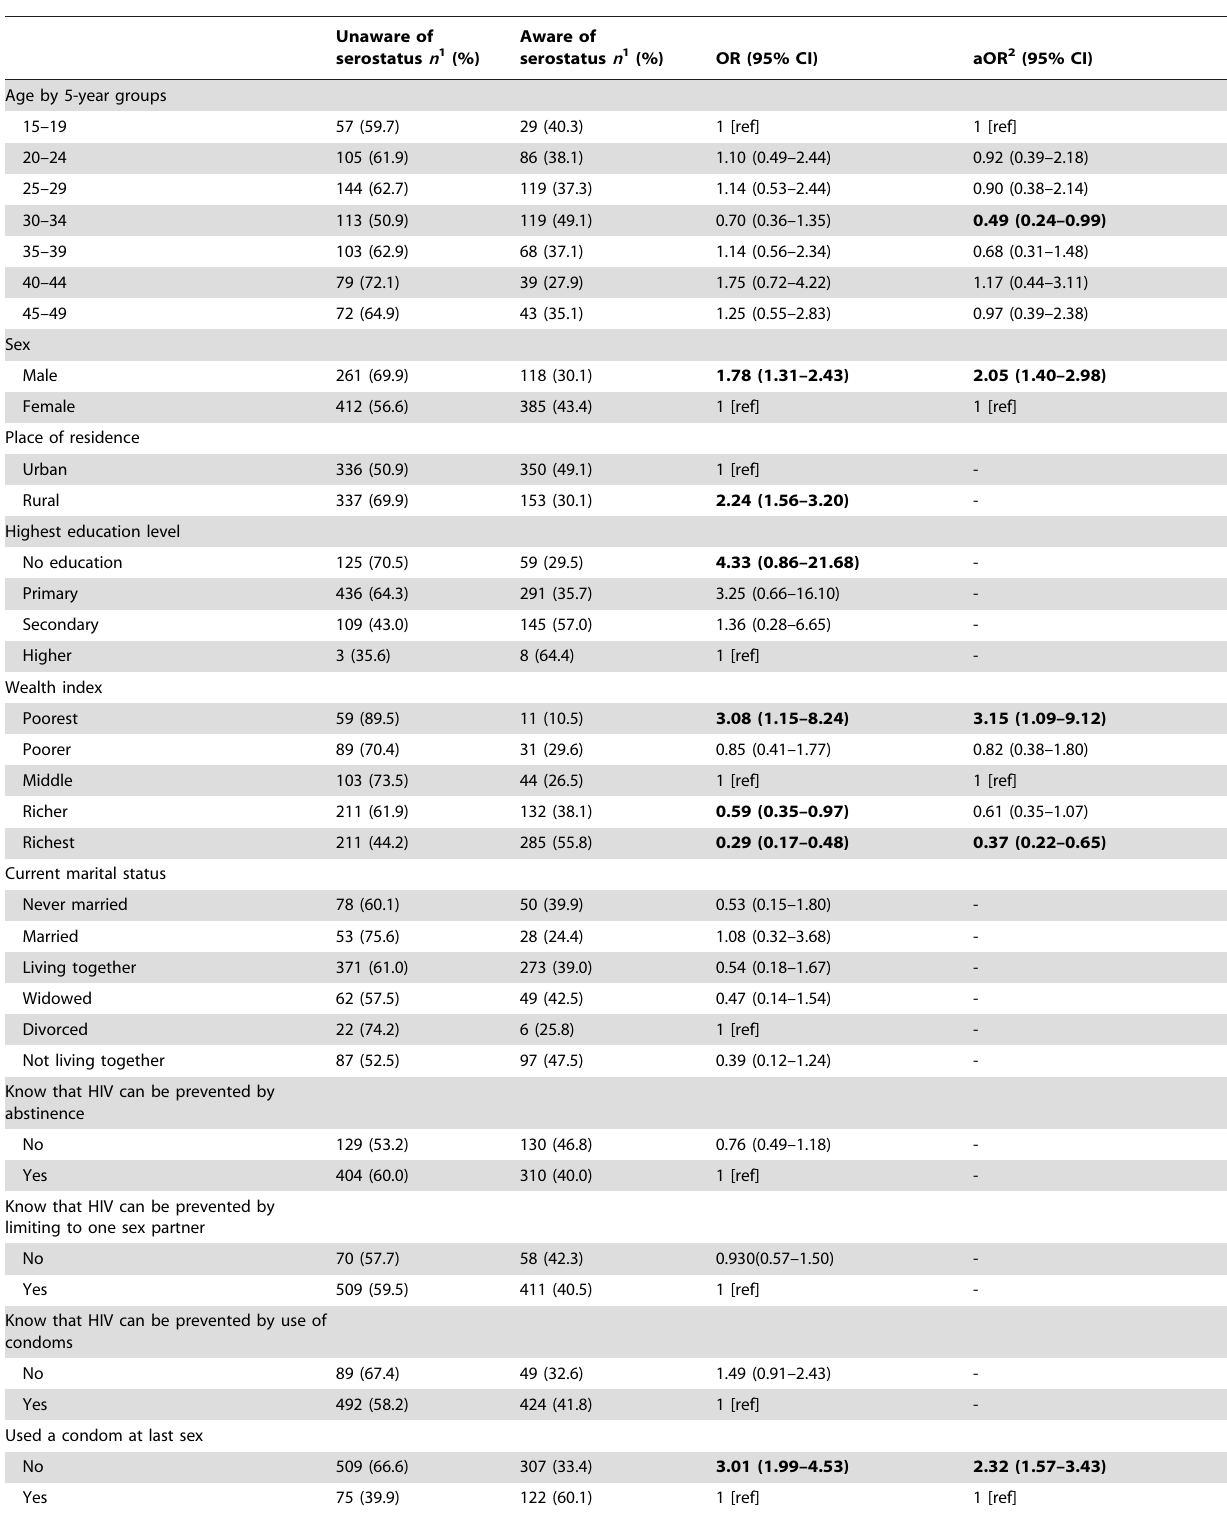
Table 1. Characteristics of People Living With HIV by awareness of serostatus, Mozambique – 2009, [N